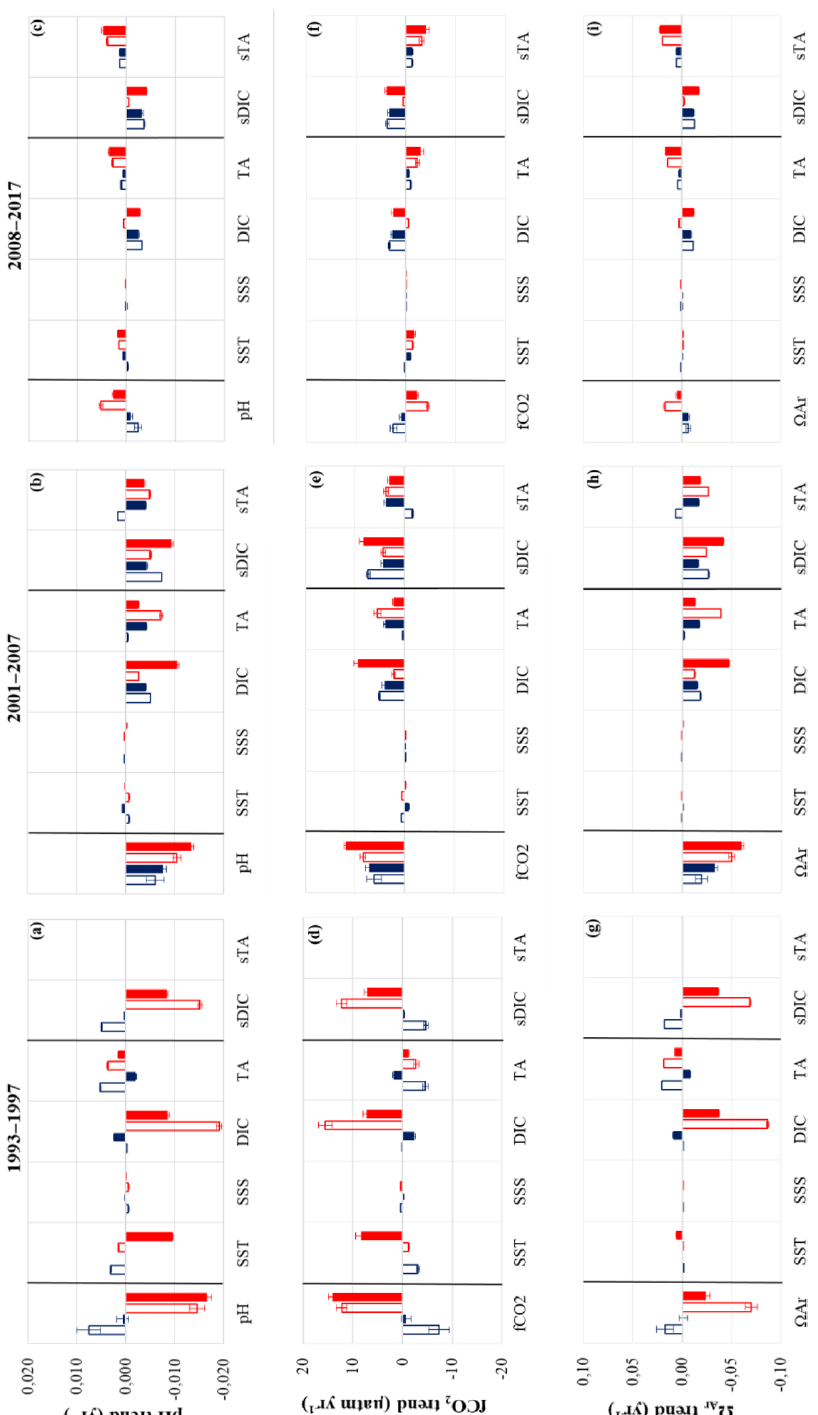
Figure 5. Decomposition of the trends in surface pH (a–c) , f CO 2 (d–f) and (cid:127) Ar (g–i) according to Eq. (2). The effect of the changes in SSS, SST, DIC, TA and the normalized part (sDIC and sTA) is shown for the three periods: 1993–1997 (left column), 2001–2007 (middle column) and 2008–2017 (right column). Color coding is the same as in Fig. 4. Here, DIC (or TA) represents the total carbon (or total alkalinity) part, whereas sDIC (or sTA) is the part of the DIC (or TA) driver not related to salinity (see explanations for Eq.